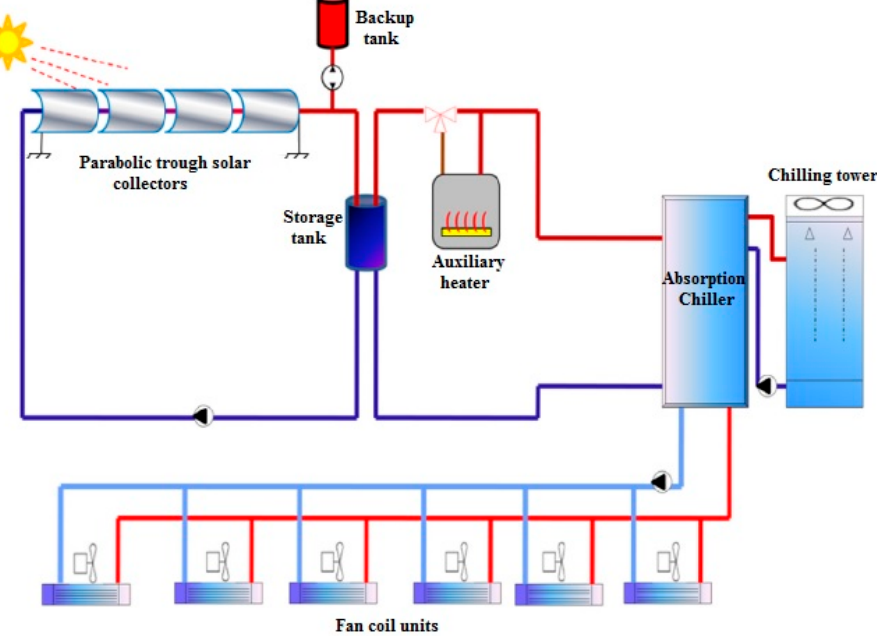
Figure 4. An absorption cooling system coupled with parabolic trough solar collectors. Reprinted with permission from Ref. [88]. Copyright 2013